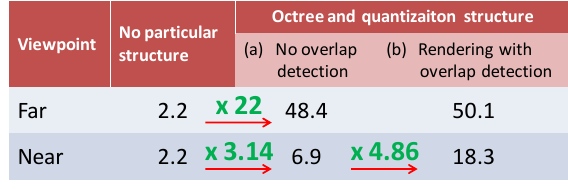
Table 4. Value of FPS